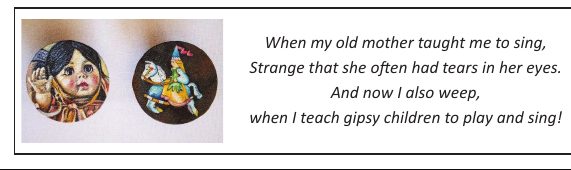
FIGURE 13: ‘My Song Sounds of Love’.